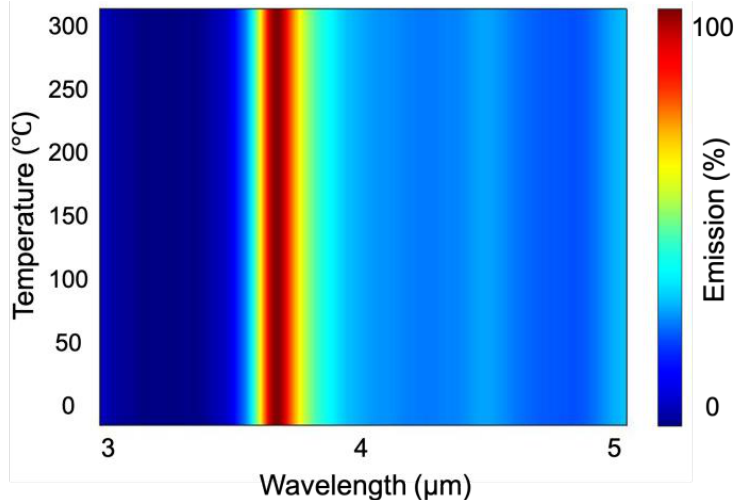
Figure 8. Thermal stability of the metasurface. The color bar indicates the emission intensity.